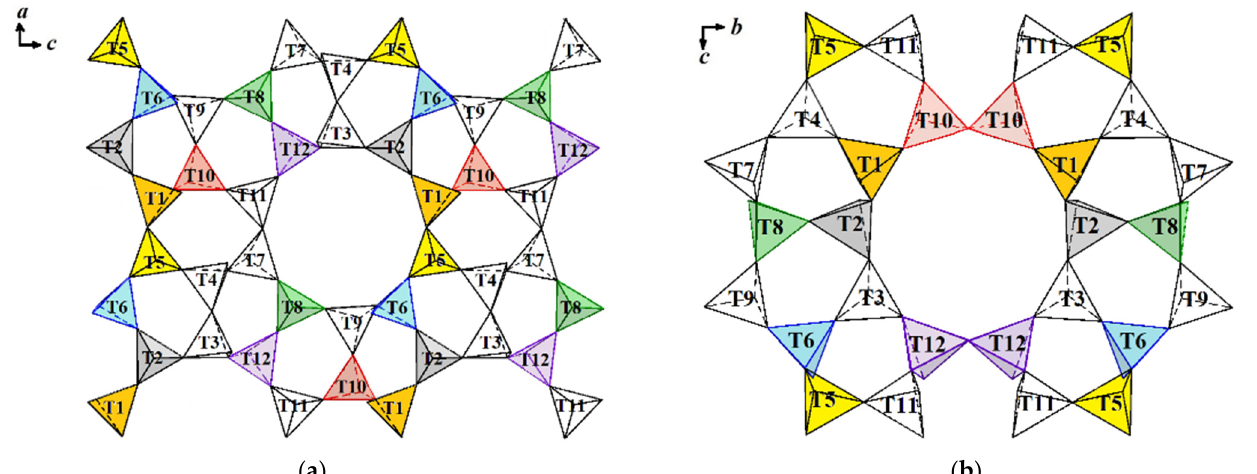
Figure 18. Combination of rings along <010>—rectilinear channels ( a ) and <100>—sinusoidal channels ( b ). Sites with Ti 4+ ions in TS-1, TS-2, TS-3, and TS-4 structures are marked with different colors: orange—TS-4, yellow—TS-2, purple—TS-3, grey—common sites of TS-1 and TS-3, blue—common sites of TS-1 and TS-4, green—common sites of TS-2 and TS-3, pink—common sites of TS-1, TS-2, and TS-3.